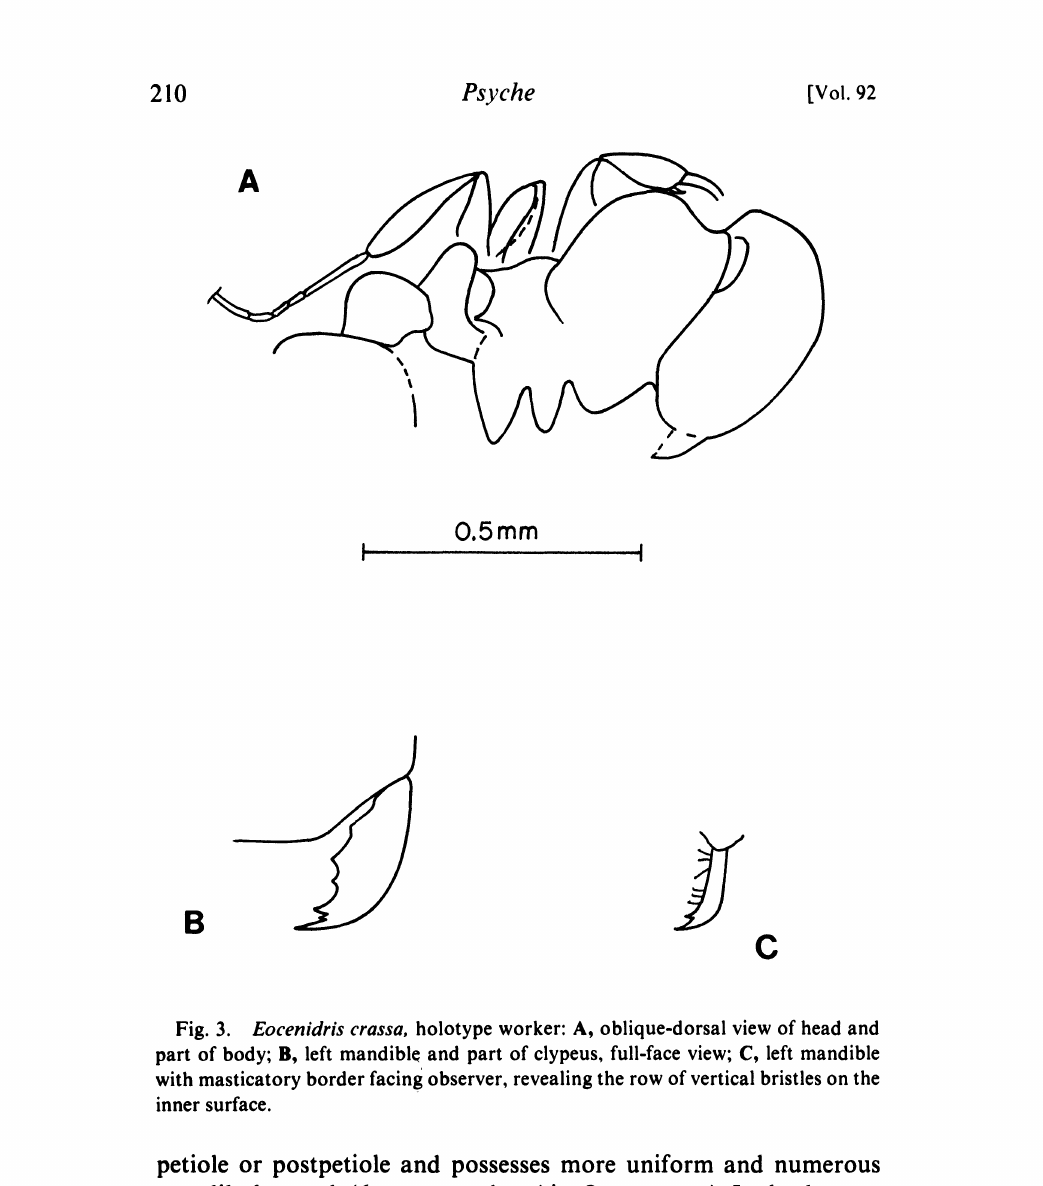
Fig. 3. Eocenidris crassa, holotype worker: A, oblique-dorsal view of head and part of body; !1, left mandible and part of clypeus, full-face view; C, left mandible with masticatory border facing observer, revealing the row of vertical bristles on the inner